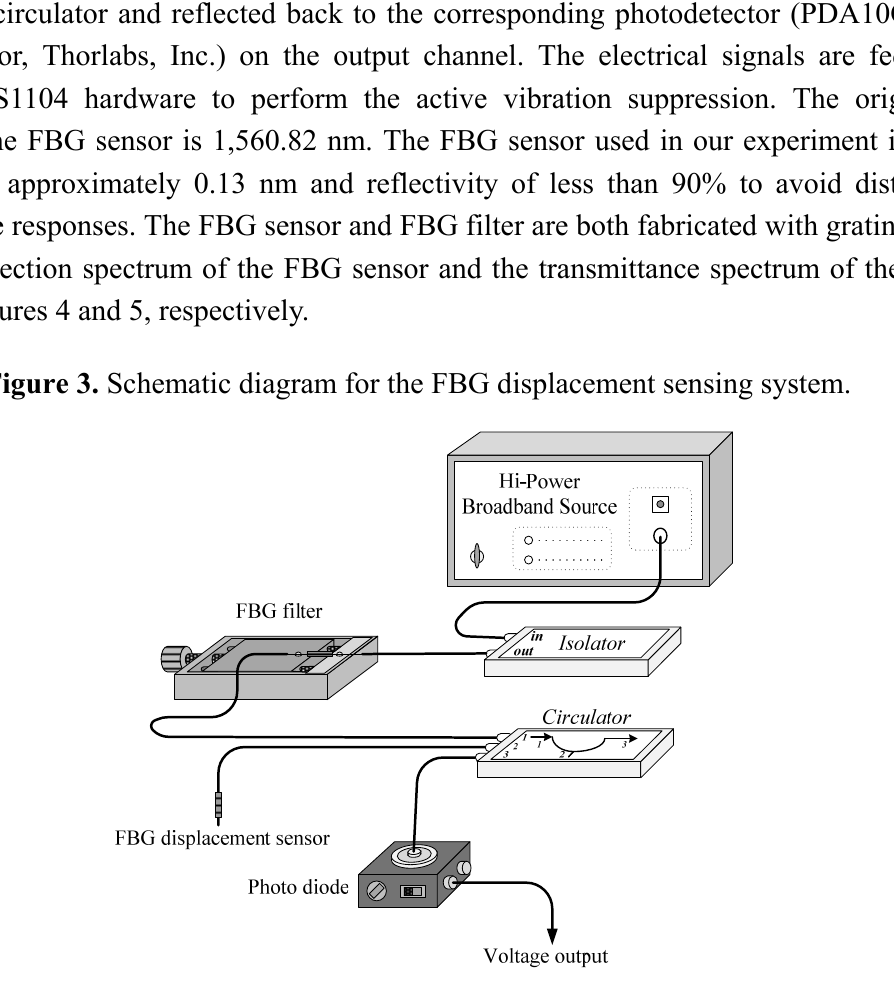
Figure 4. Reflection spectrum of the FBG displacement